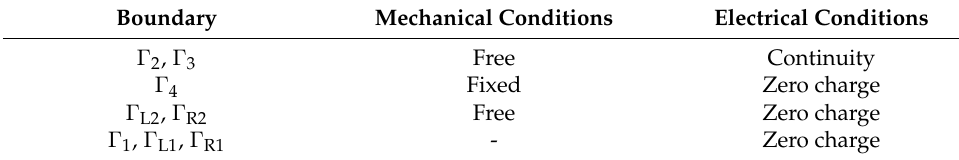
Table 5. Boundary conditions used in the 2D model of Figure